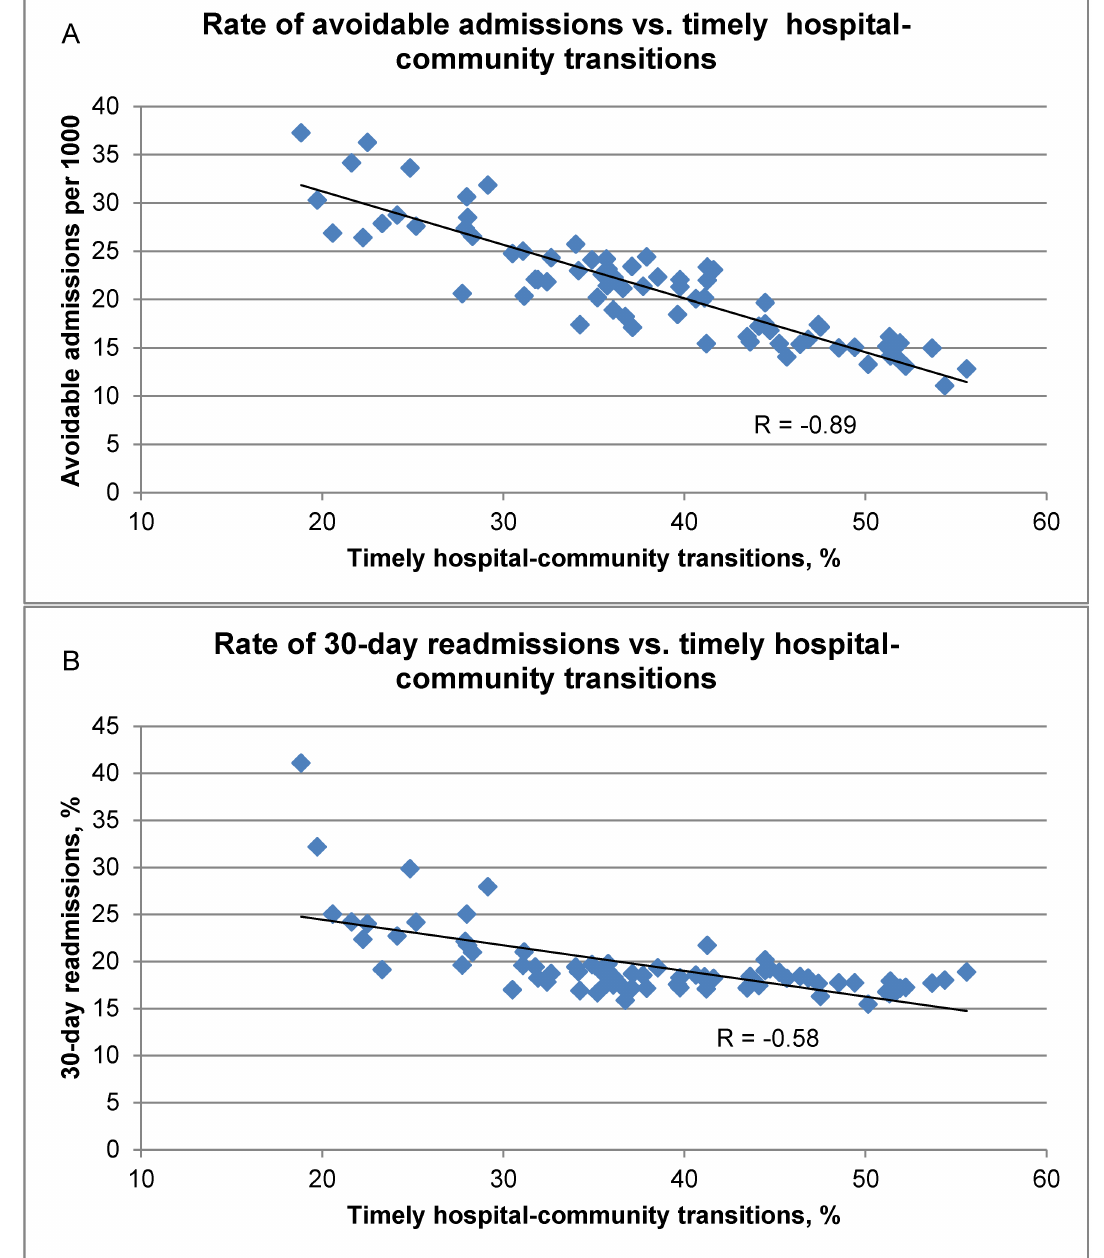
Fig 1. Rates of avoidable admissions per 1000 patients and 30-day readmissions (%) vs. timely hospital-community transitions (%). Rates of avoidable admissions and 30-day readmissions are fully risk-adjusted across all quality indicators within these domains. Quality indicators comprising timely hospital-community transitions were all age-sex adjusted, except for office visit for a newborn within 7 days after hospital discharge.